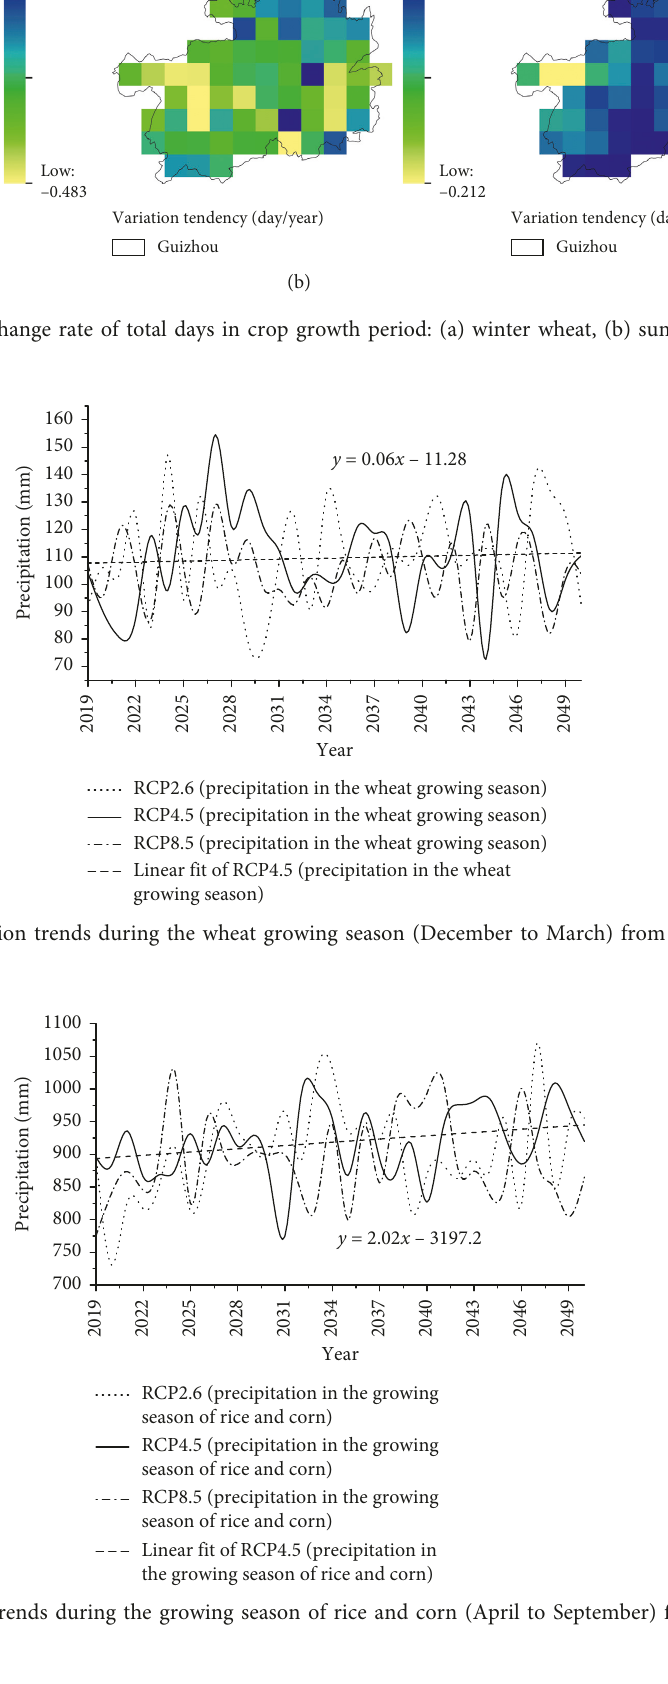
Figure 16: Precipitation trends during the growing season of rice and corn (April to September) from 2019 to